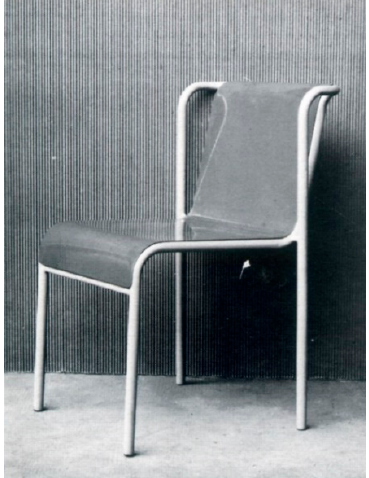
Figure 24. A stack chair, Model S5 by Gabriele Mucchi (1934–1935). Chromium plated steel structure and sheet steel seat. Photo from (Selvafolta 1980, p. 46).